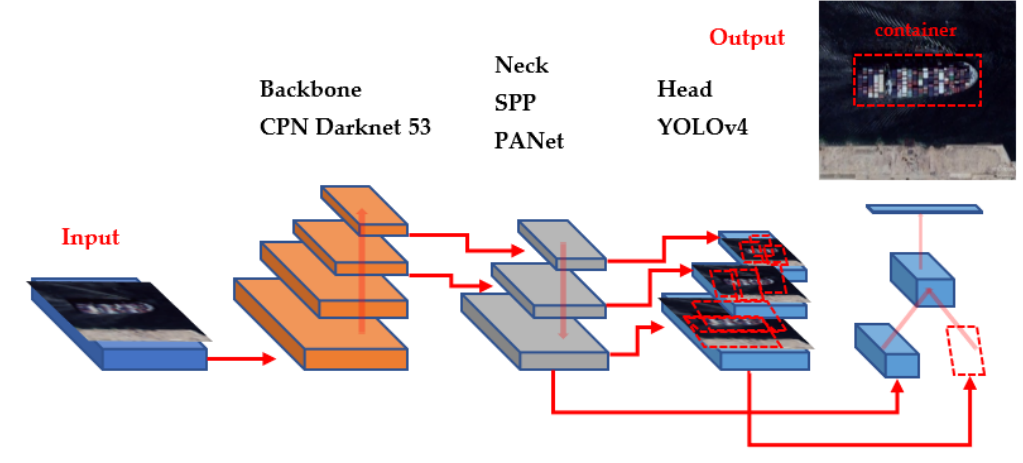
Figure 2. YOLOv4 architecture used for localization.